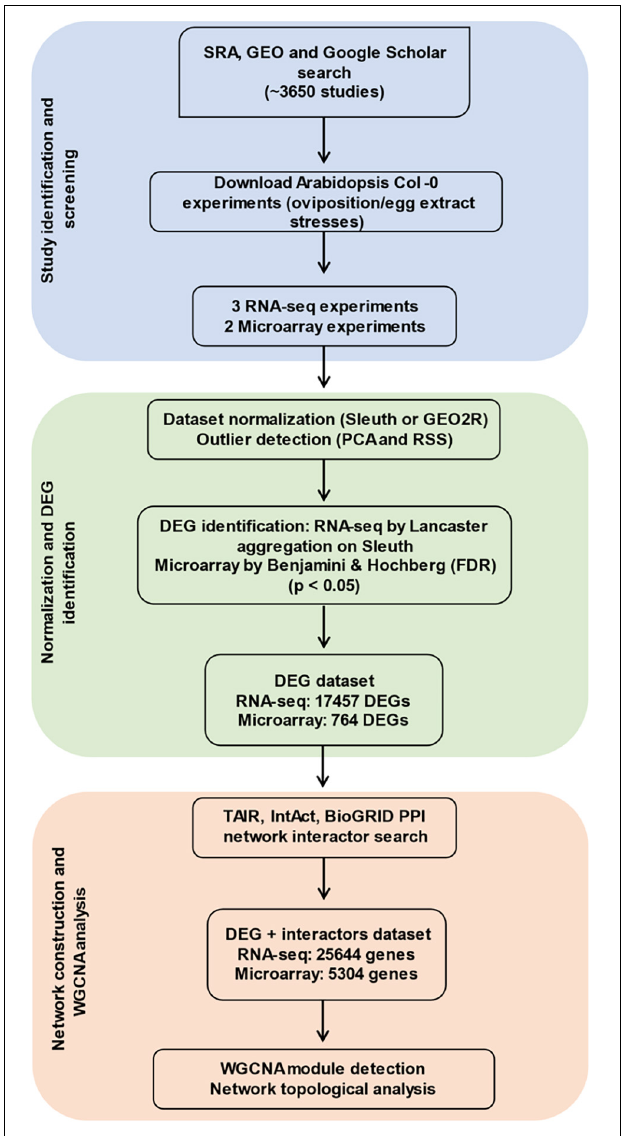
FIGURE 1 | Workflow for data collection, curation, and co-expression network analysis. In total, five different studies passed the filter and were analyzed by identifying differentially expressed genes (DEGs) from them. Experiment-based interactors of the DEGs were searched from databases, and co-expression based on each experimental data was determined. Significant groups of genes plus interactors (modules) were obtained and